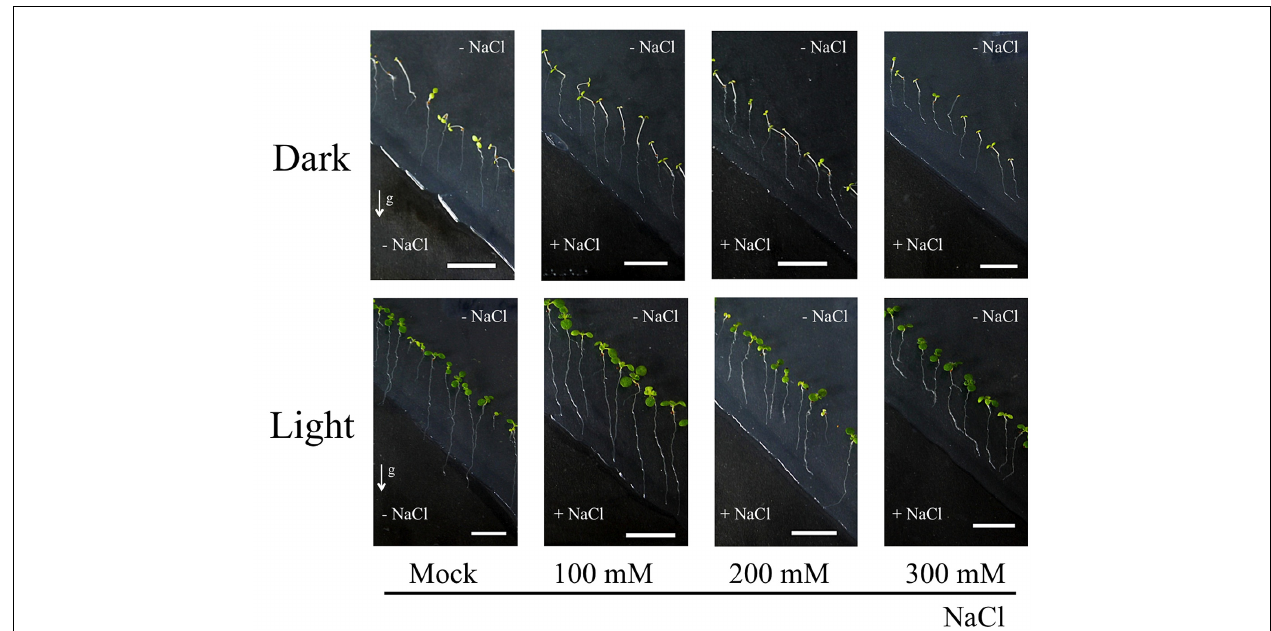
with 0, 100, 200, and 300 mM NaCl media in the bottom half of Petri dishes. The method used for imposing the root halotropism is following exactly the protocol as published by Galvan-Ampudia etal. (2013).White arrows indicate the gravity vector. All seedlings were grown in vertical position. Bar indicates 1 cm.